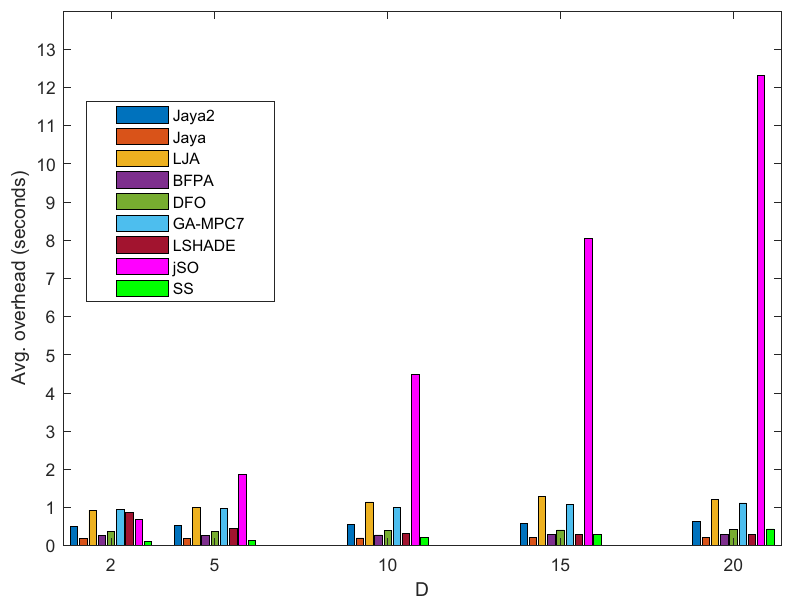
Figure 9: Average algorithmic overhead ( in seconds ) for the competing algorithms, over increasing dimensionality